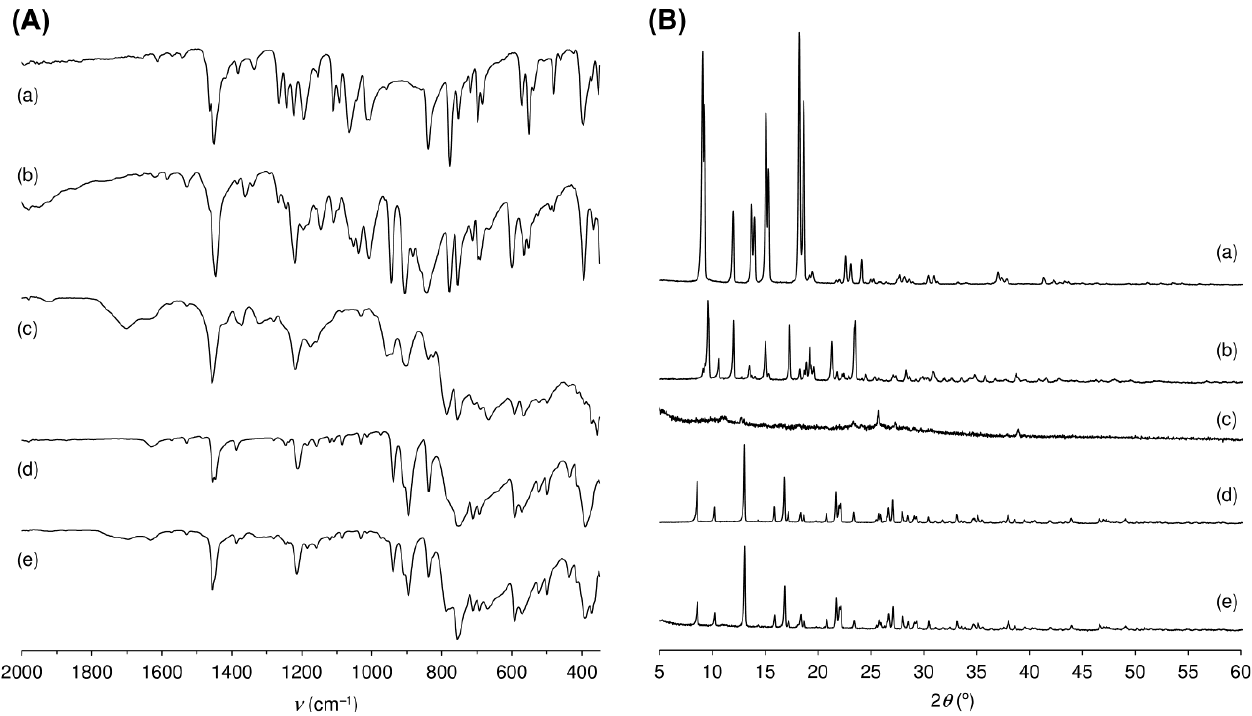
Figure 6. ATR FT-IR spectra ( A ) and powder XRD patterns ( B ) of (a) Hpto, (b) 1 , (c) 1 -used, (d) 2 , and (e) 2 -used. ( e ) 2